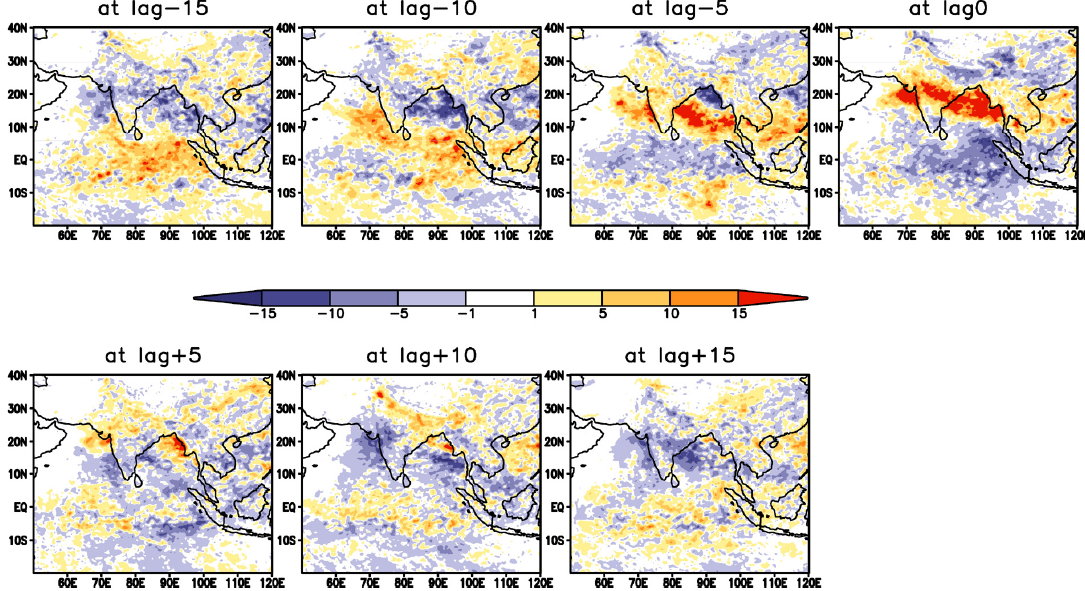
Fig. 5. Lag composite of precipitable ice (mgm − 3 day − 1 ) during active spells based on CIPI using TRMM 2A12 data for the period 1998– 2008.